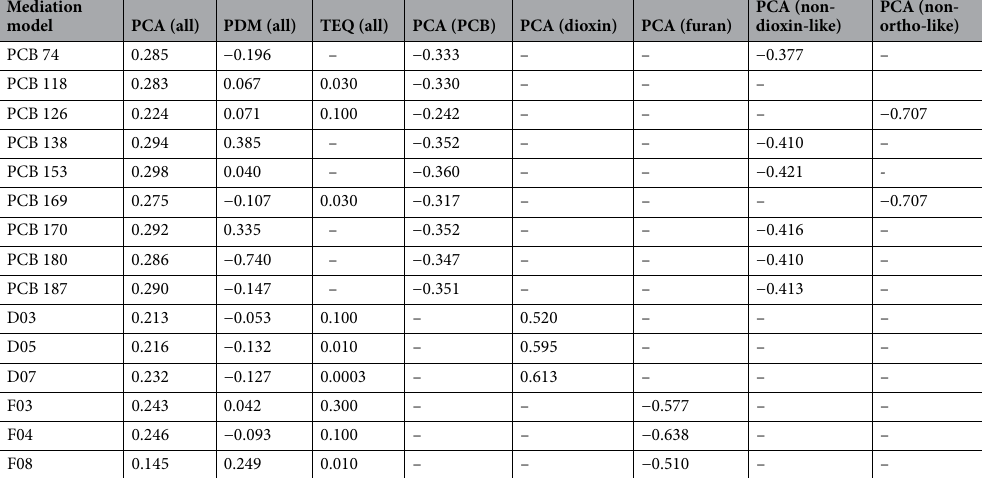
Table 4. Exposure score weights for different analytic models considered.